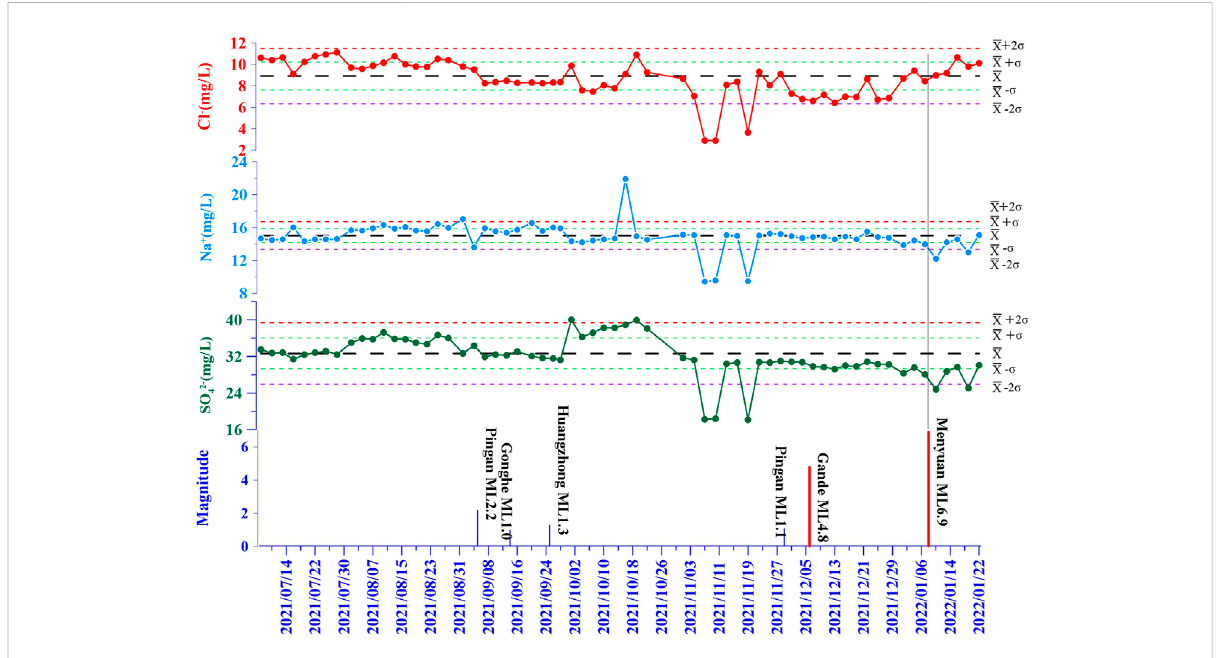
FIGURE 8 Temporal variation of water and seismic response in the S22 spring (the blue vertical line indicates the earthquakes above M s 1.0 within the scope of 50 km, the red vertical line indicates the earthquakes above M s 4.0 within the scope from 50 to 300 km. The duration of data monitoring is